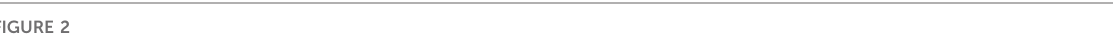
FIGURE 2 generated from an initial population of 1 × 10 5 CMs were obtained each day from D0 – D7 (bar = 500 μ M). (D) Spheroid diameters of all 3 groups (C1 black; C3 yellow; C4 blue) were measured on D7, D30, and D60; results are displayed as violin plots. (E) Spheroids were cut into 10-µm sections and stained with Masson-trichrome; representative images are displayed for every 10th sequential section from a C4 spheroid on D60 (bar = 500 μ M). (F) Representative images are displayed for the centermost sections from C1, C3, and C4 spheroids at the indicated time points (bar